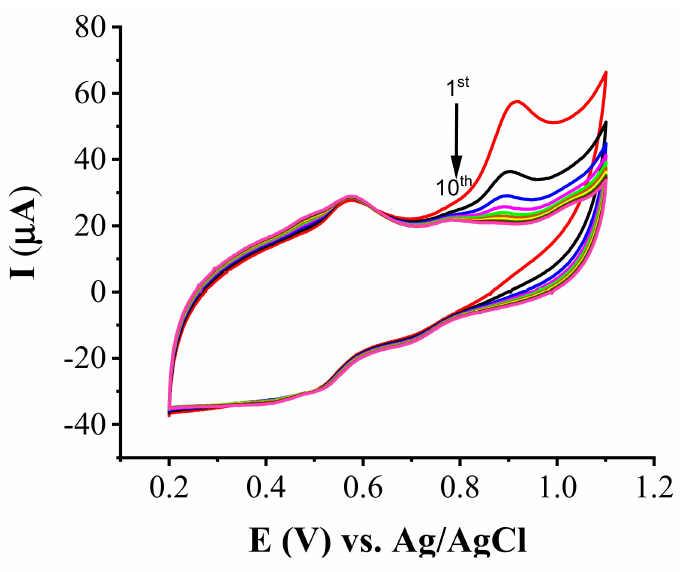
Figure 4. CV removal of entrapped NLX using 0.5 M H2SO4 at a scan rate of 50